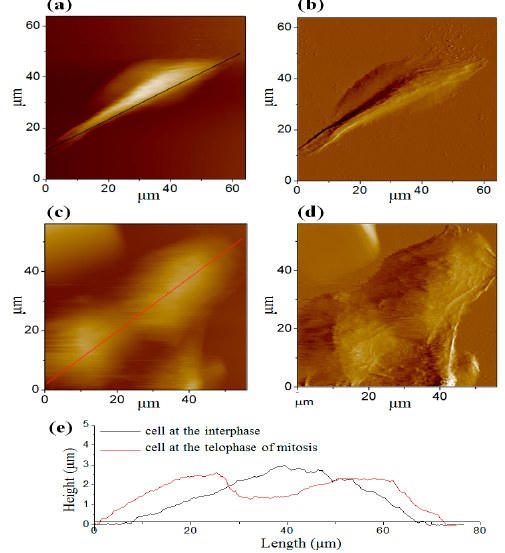
Figure 2. Atomic force microscopy (AFM) images of the osteosarcoma cell. ( a ) Topographic image of the cell at the interphase; ( b ) deflection image of the cell at the interphase; ( c ) topographic image of the cell at the telophase of mitosis; ( d ) deflection image of the cell at the telophase of mitosis; ( e ) two cross-sectional profiles of the cell shown in ( a ) and ( c ) (the positions of the cross-sections were marked by black and red lines,